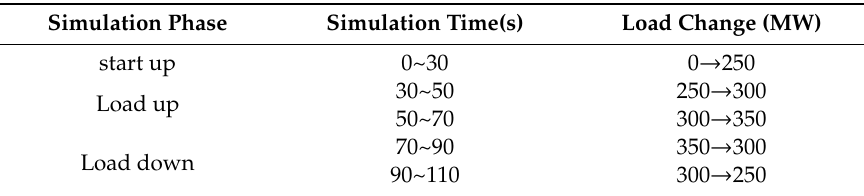
Table 7. Load dynamic simulation conditions of the CFB boiler.